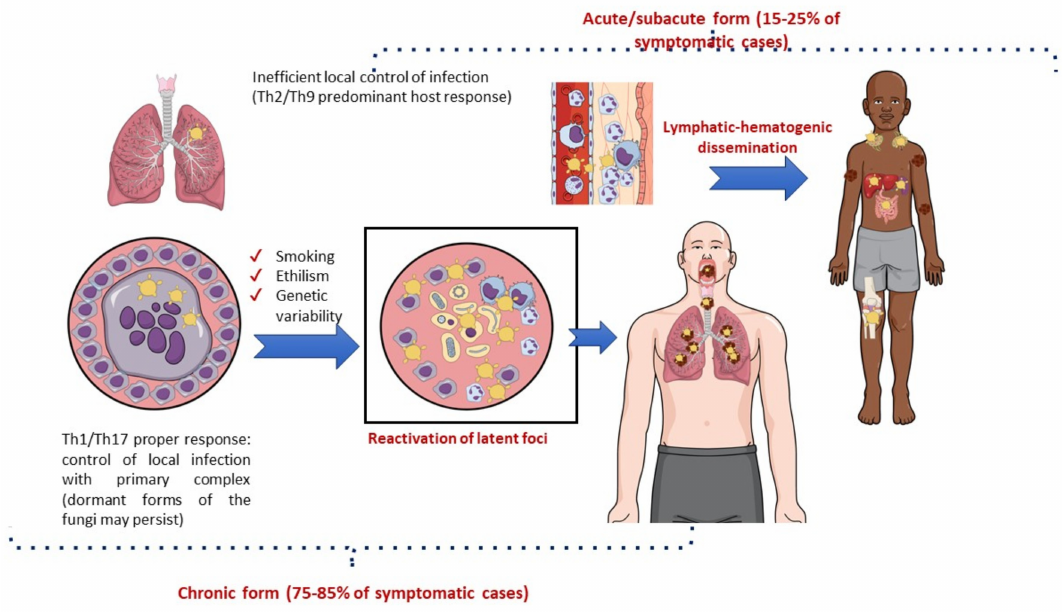
Figure 5. Natural history of paracoccidioidomycosis with a focus on